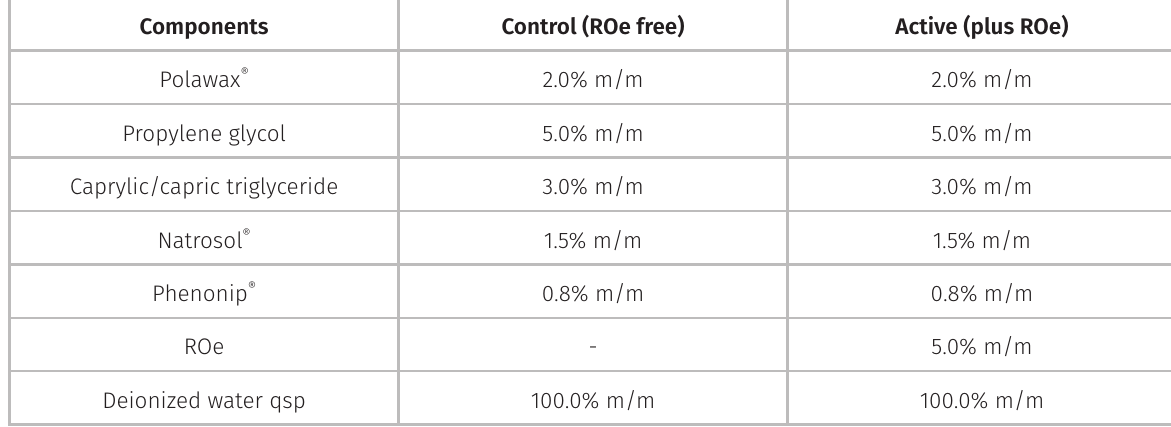
Table I. Composition of the emulgels used in the investigation of the in vivo efficacy of ROe in preventing UVB irradiation damage to the